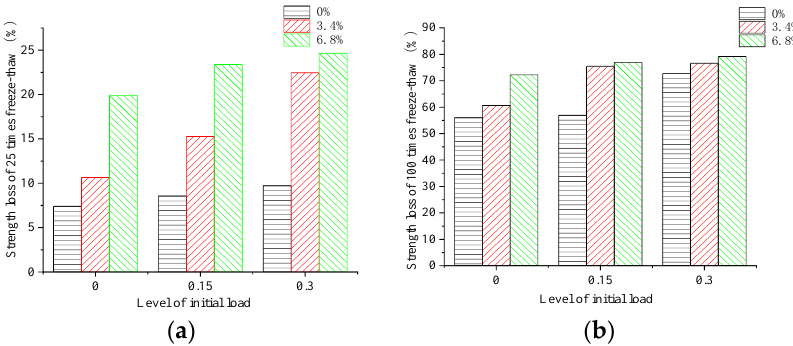
Figure 3. Change in the compressive strength with three levels of initial load. ( a ) After 25 freeze – thaw cycles. ( b ) After 100 freeze – thaw cycles.